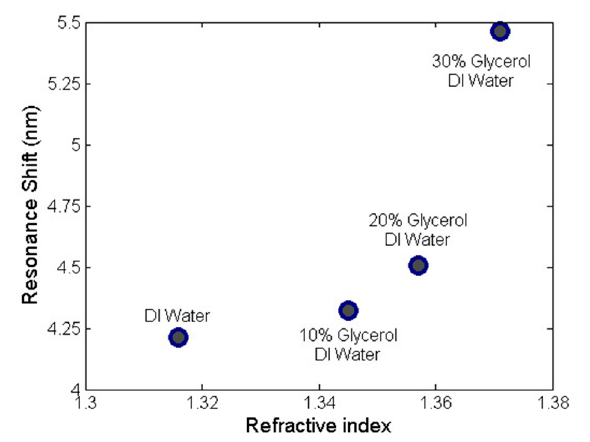
Figure 6. Measured resonance shift vs. cladding refractive index for a 900-nm-thick TeO 2 microcavity coated in solutions with varying concentrations of glycerol and water.